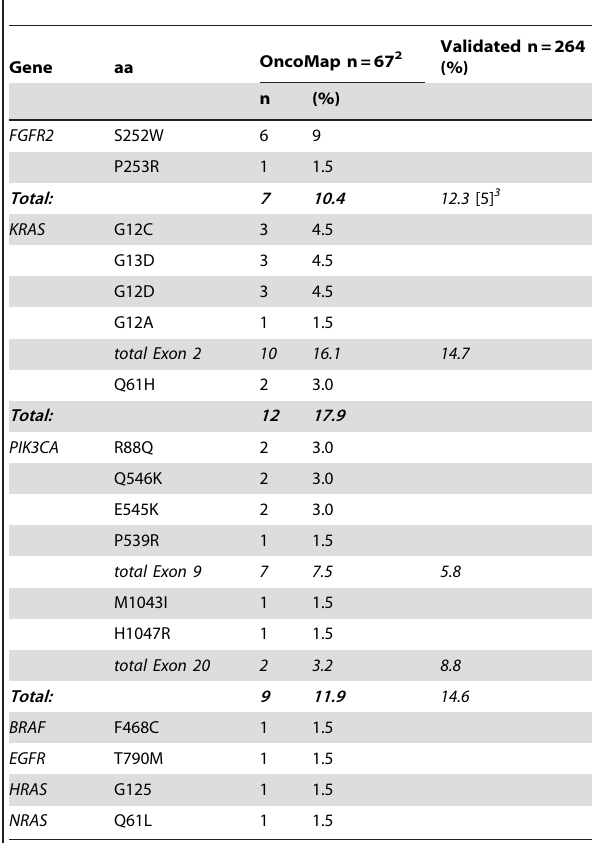
Table 3. Frequency of mutations in 67 1 primary lesions from endometrial cancer patients.